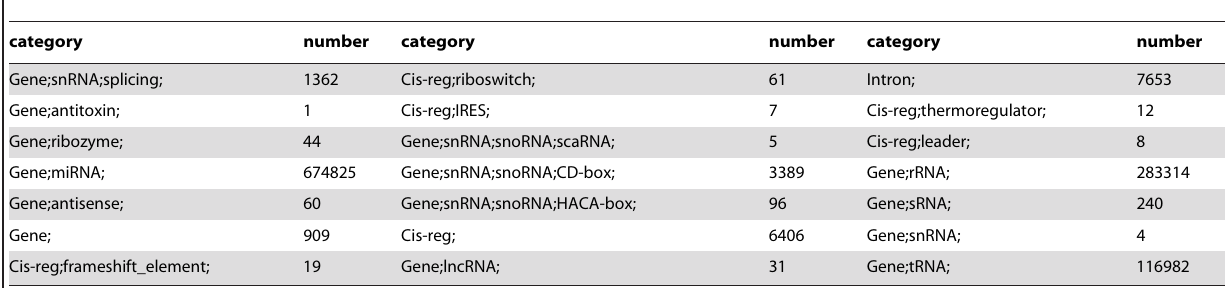
Table 4. Statistics of small RNAs in Amorphophallus konjac.